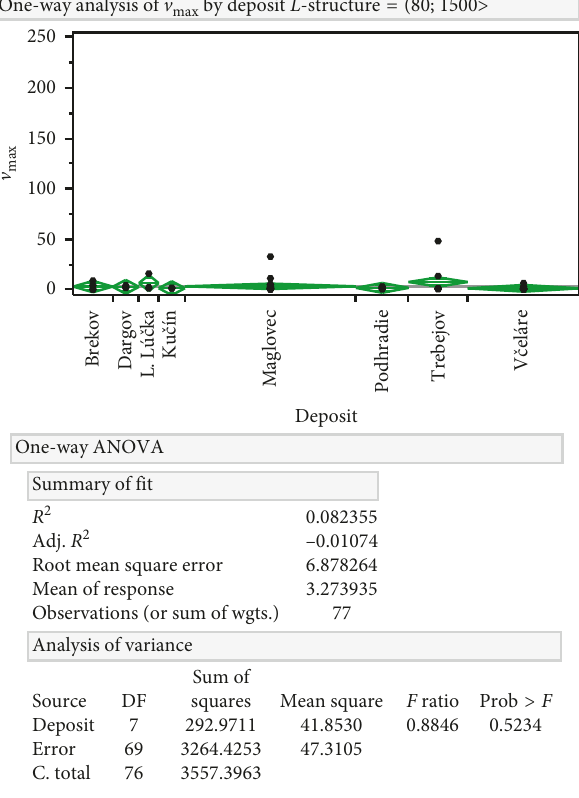
-deposit, distance over max